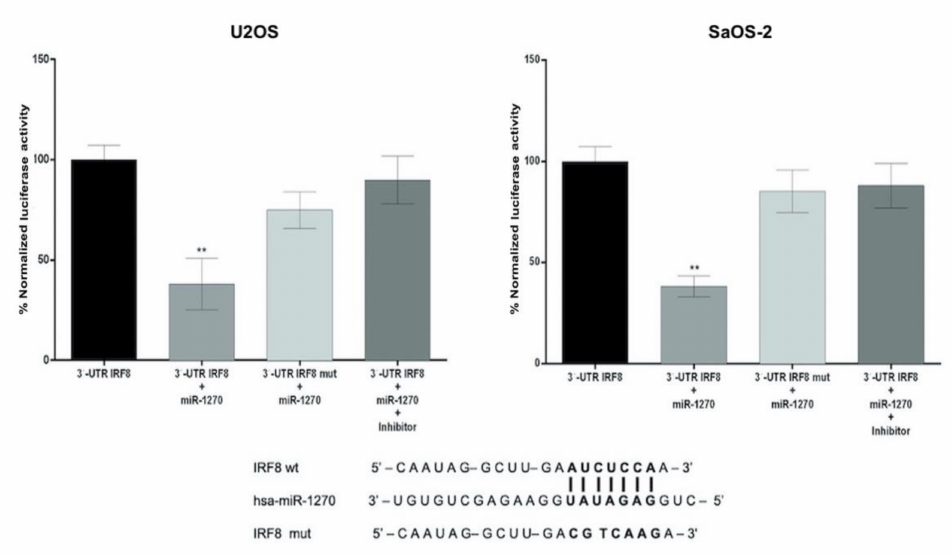
Figure 1. miR-1270 directly targets IRF8 3 (cid:48) -UTR. The binding sequence of miR-1270 on IRF8 3 (cid:48) -UTR is shown. The luciferase activity was measured in cells co-transfected with wild-type or mutant pmiR- Target-IRF8_3 (cid:48) -UTR and miR-1270 mimics/inhibitor. Data are expressed as the mean ± SD from three independent experiments. Non-parametric Mann–Whitney U test was performed. ** p < 0.01. miR-1270, microRNA-1270; IRF8, interferon regulatory factor 8; 3 (cid:48) -UTR, 3 (cid:48) -untranslated region. miR-1270 promotes IRF8 downregulation . It has been reported that osteoclasts interact with osteoblasts [17,18,25]. Therefore, herein, miR-1270 was overexpressed in osteoblast- like cells. Since miR-1270 was overexpressed in circulating monocytes (osteoclast pre- cursors), which in turn could interact with osteoblasts, the current study